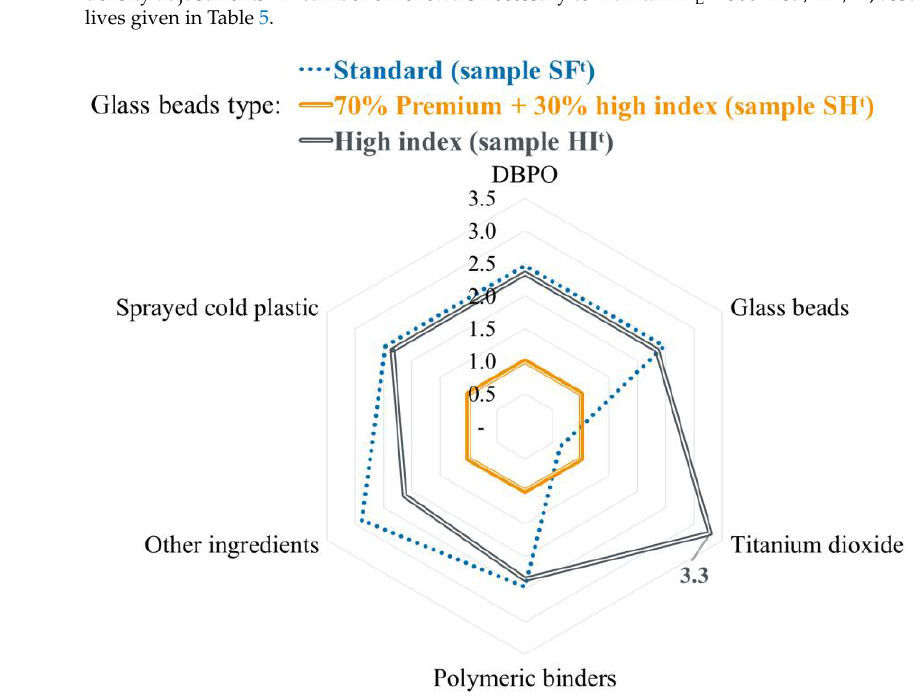
Figure 11. Relative long-term material consumption to maintain R L > 500 mcd/m 2 /lx for 1 × 10 8 tyre passes (turntable testing). The sample SHᵗ ( 70% premium GB mixed with 30% high index GB) was defined as 1.0 (arbitrary unitless scale).